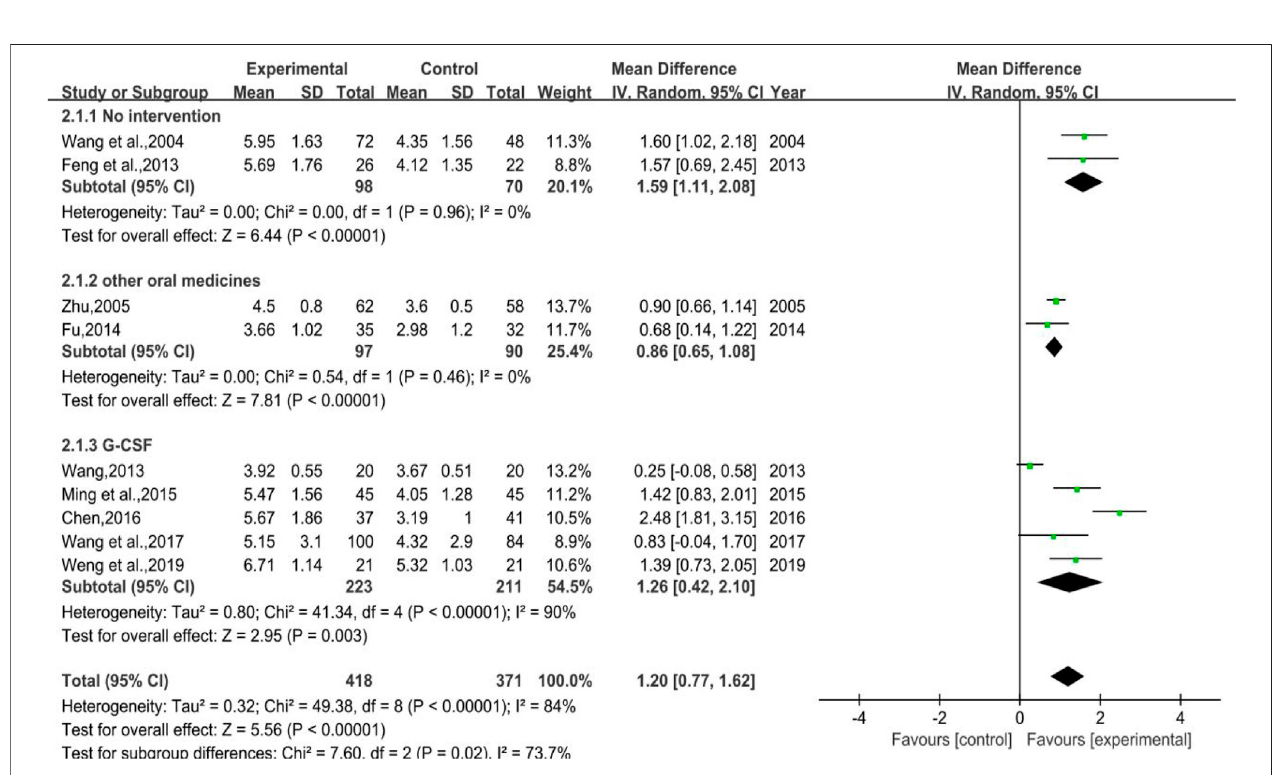
FIGURE 12 | The forest plot of white blood cell count in therapeutic